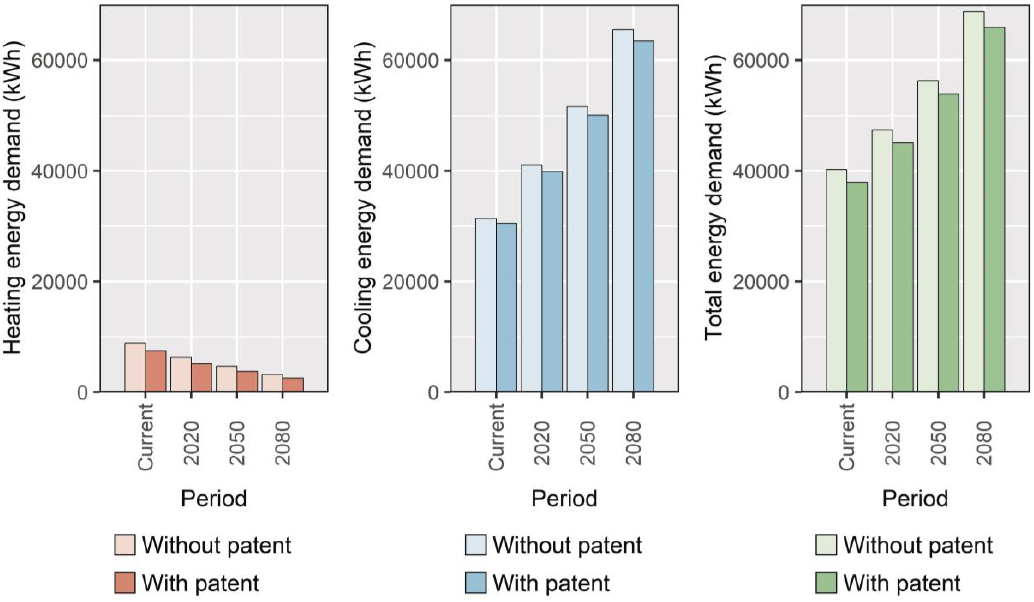
Figure 11. Global energy demand of the building for the different scenarios considered.